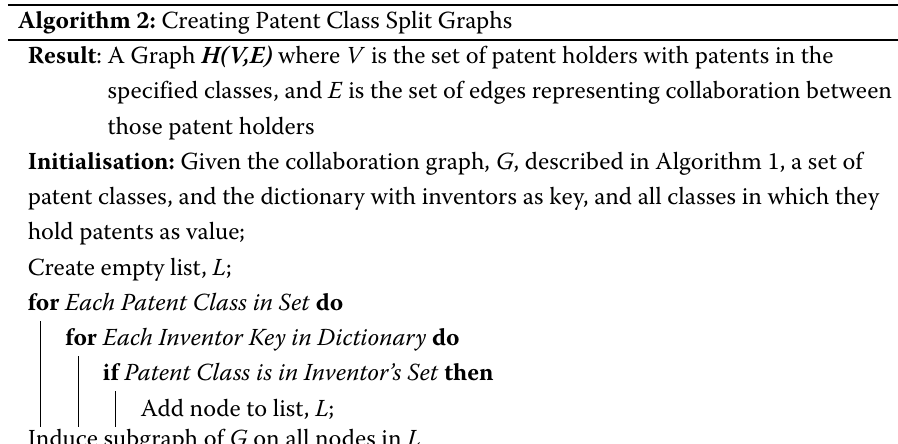
Algorithm 2: Creating Patent Class Split